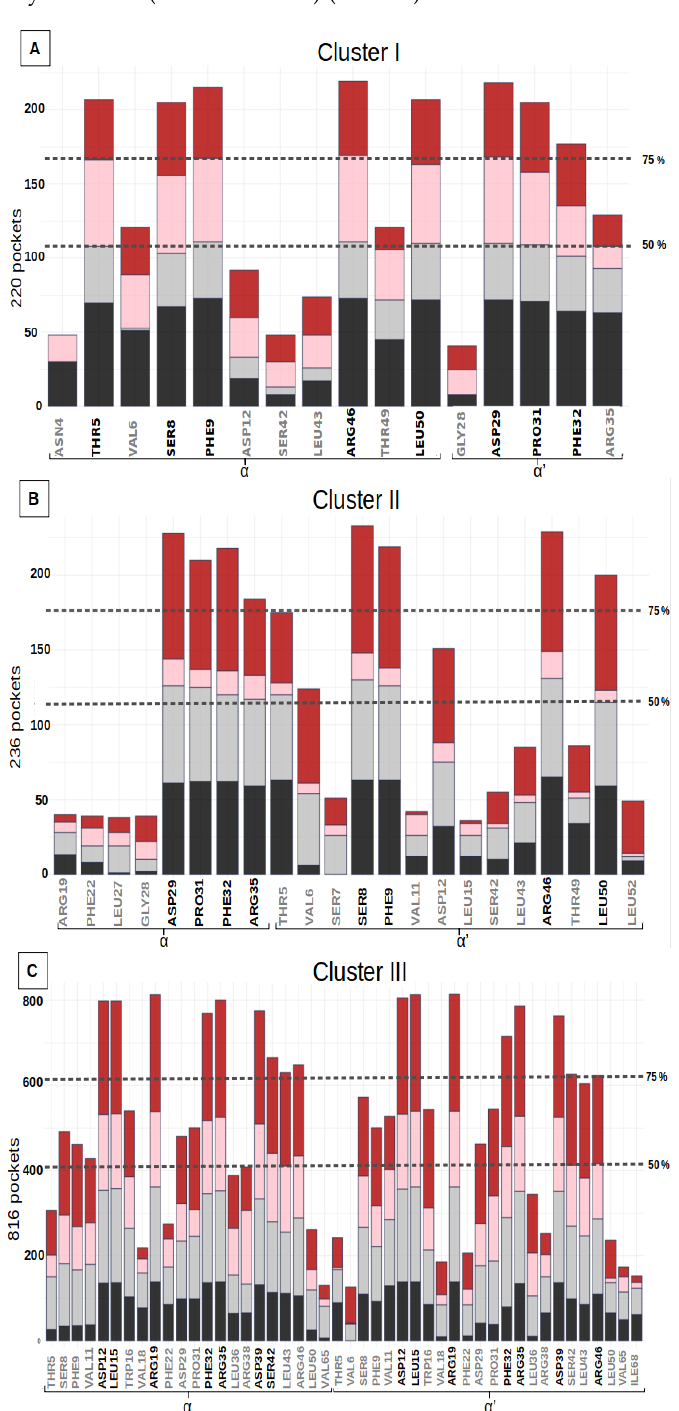
Figure 3. Residue frequency histograms of the druggable groove-pockets (for residues in more than 15% of the pockets) for the three clusters: ( A ) Cluster I, ( B ) Cluster II, ( C ) Cluster III. The bars in the histograms represent the distribution of the number of pockets, including a specific residue for each of the structures H6N6_c, H6N6_so_o, H1N1_so_c, H5N1_o shown in black, gray, pink and red respectively. Two dotted lines indicate the residues seen in more than 50% and 75% of the pockets in the class studied, and the residues selected as key residues in each class are shown in black on the X axis.